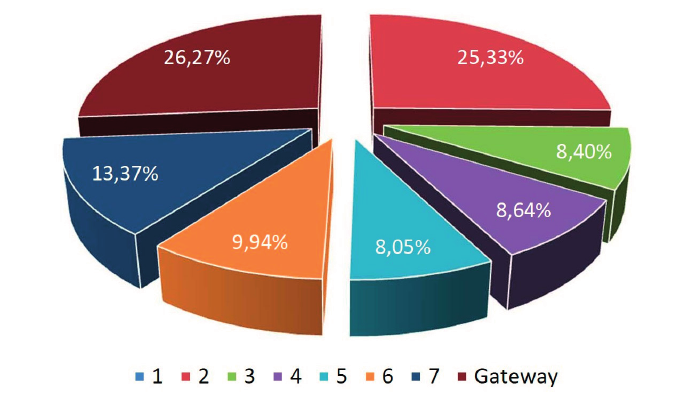
Figure 21. Rate of messages lost by